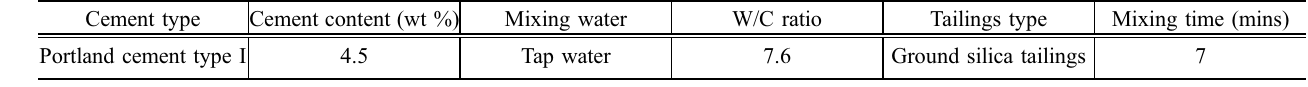
Table 1 Mixture recipe for preparation of CPB samples.